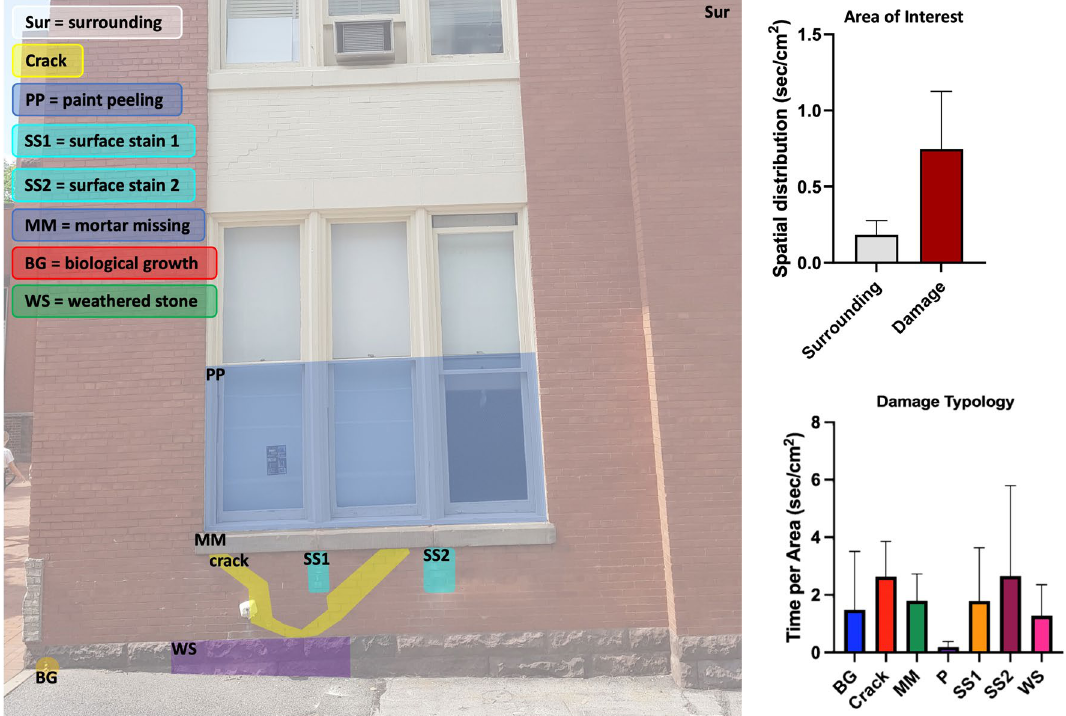
Figure 4. Total fixation time on different damage areas of interest (AOIs) during visual inspection; (left) location and size of AOIs (bottom-left) total fixation duration of damage to surrounding areas; (top-right) comparison of participant’s overall spatial distribution of surrounding vs. damage areas;(bottom-right) breakdown of total spatial distribution to individual damage type fixations for all